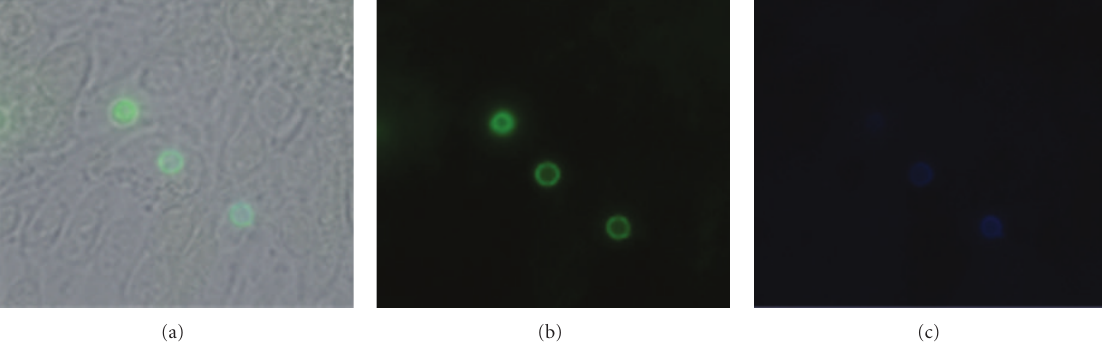
Figure 2: Fluorescence microscopy to determine adherent and internalized Cryptococcus neoformans on brain microvascular endothelial cells. C. neoformans serotype A strain H99 cells were prestained with FITC (green) before 4hr incubation with brain endothelial cells and then counterlabelled with Calcofluor White (blue) to label extracellular adherent yeasts. (a) Merged image to reveal both endothelial cells and associated yeast cells, (b) and (c) Fluorescence images revealing the FITC and Calcofluor stained yeast cells,